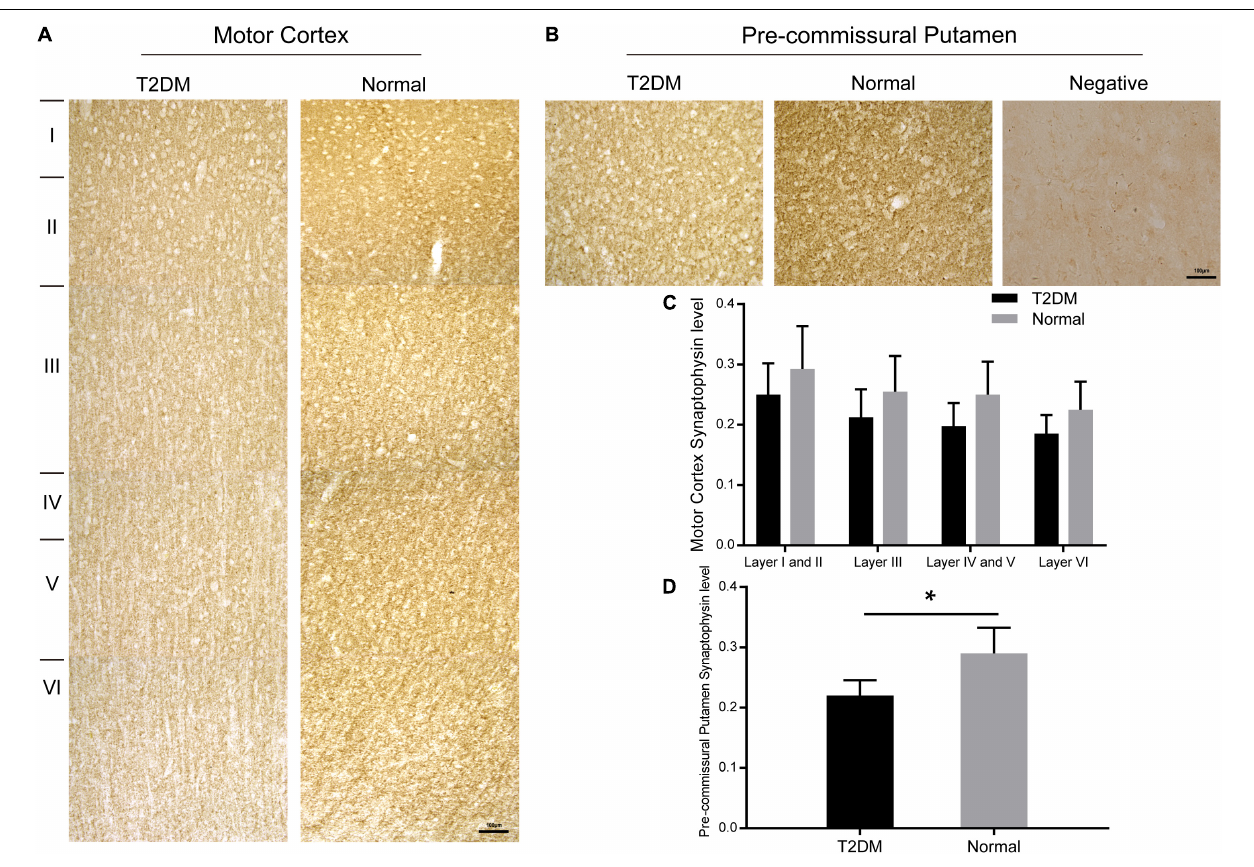
FIGURE 8 | Immunohistochemically stained motor cortex (A) and pre-commissural putamen (B) with a synaptophysin antibody from a T2DM monkey (left) and an age-matched normal monkey (right). High power images were also shown in Supplementary Figure S4 . Quantitative analyses of the immunohistochemical intensity of synaptophysin in the motor cortex (C) and in the pre-commissural putamen (D) . A negative control image without the primary antibody incubation was also shown (right, in B ). Data was represented with the mean ± SE ( n = 5 ∼ 7), * p < 0.05. Scale bars = 100 µ m in (A,B) .